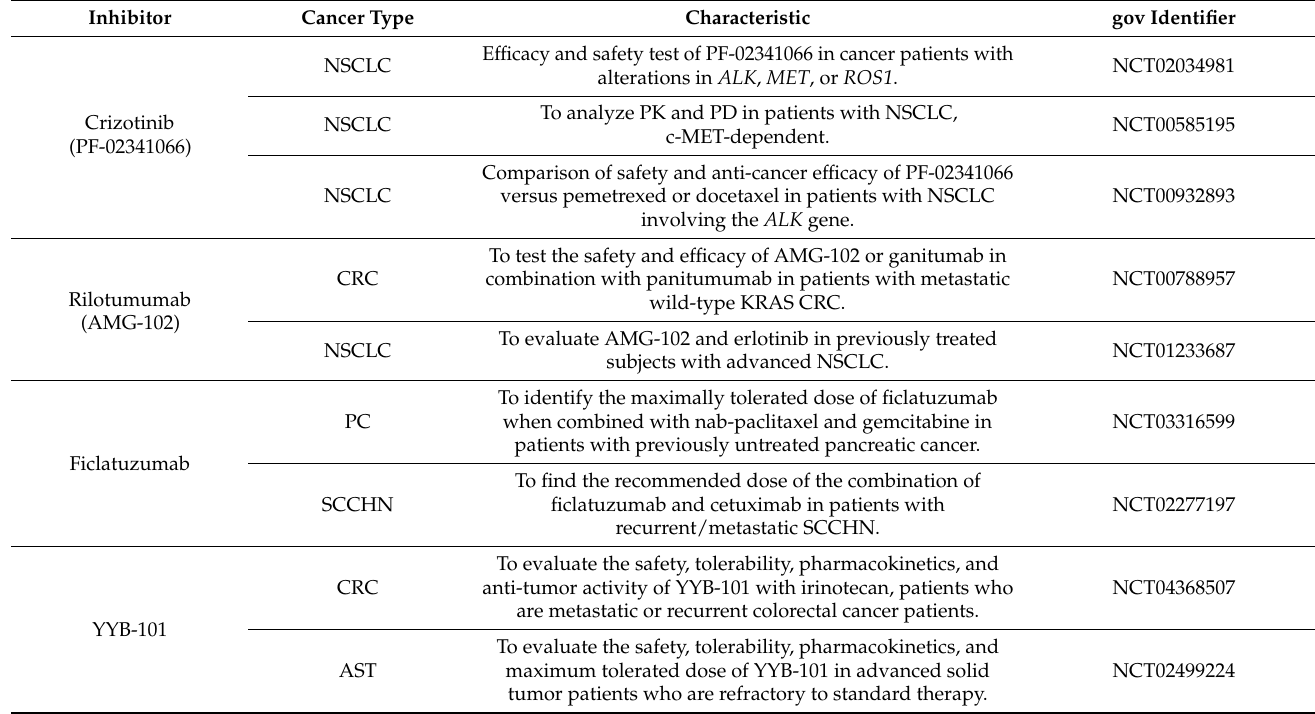
Table 1. Clinical trials of targeting of HGF/c-MET in